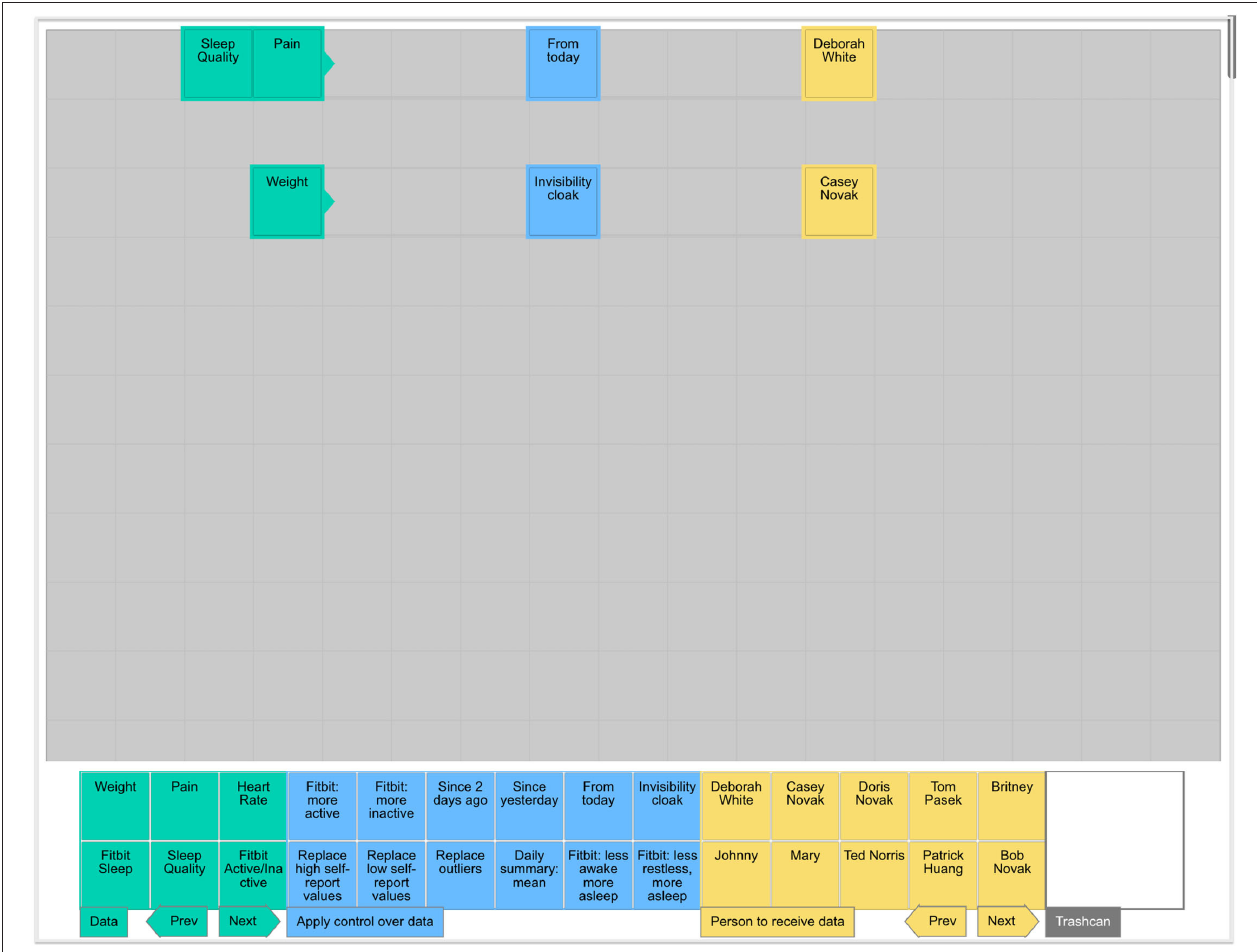
FIGURE 1 | Data Checkers (DC) has a grid-based interface for specifying sharing